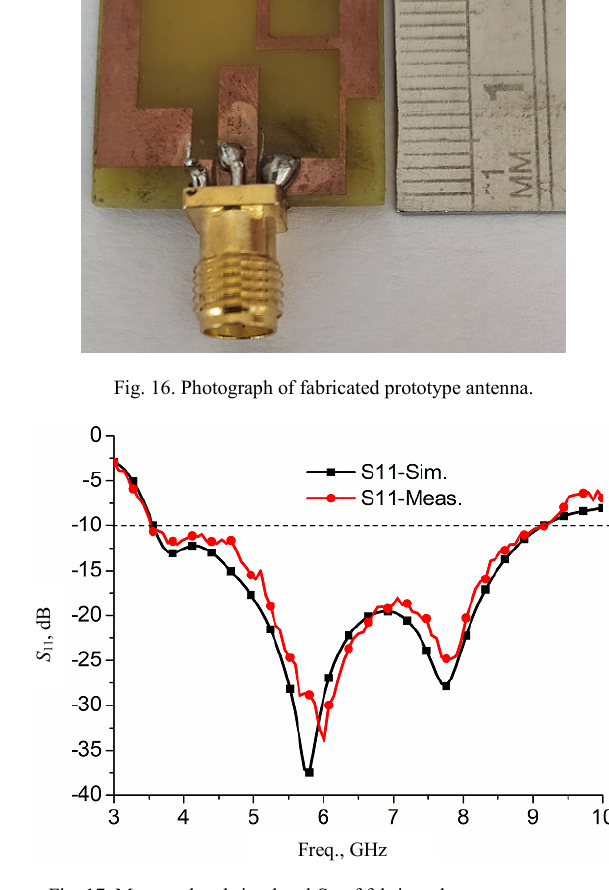
Fig. 17. Measured and simulated S 11 of fabricated prototype antenna.